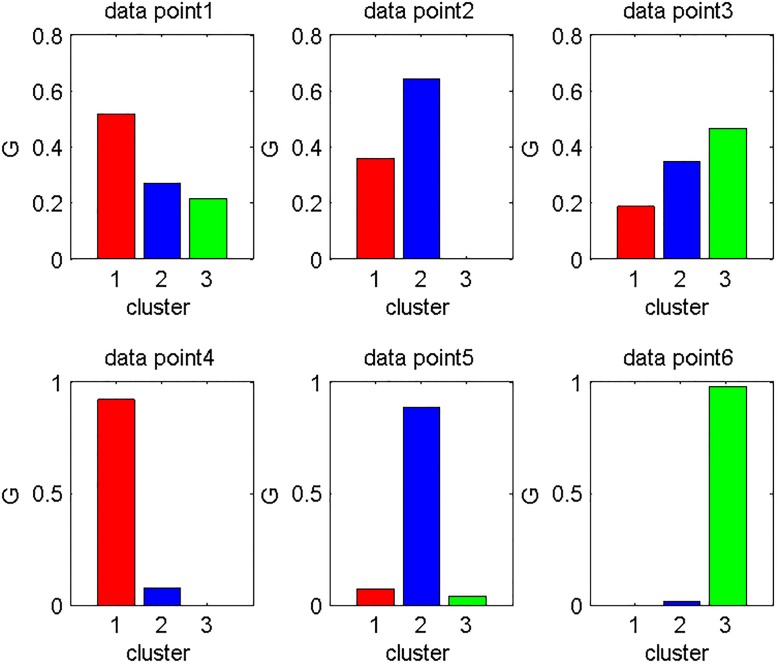
An example of the posterior G of 3 ambiguous data points and 3 sharp data points on above EKM clustering results.